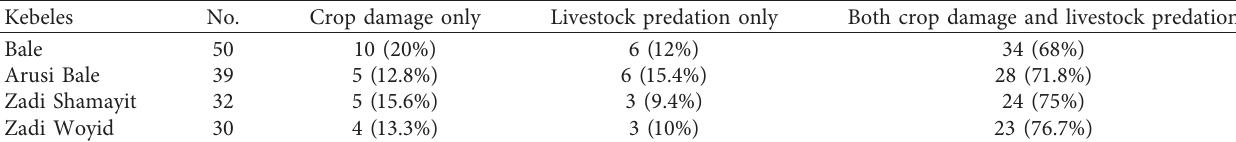
Table 2: Percentage of types of conflict by wild animals in each kebele.